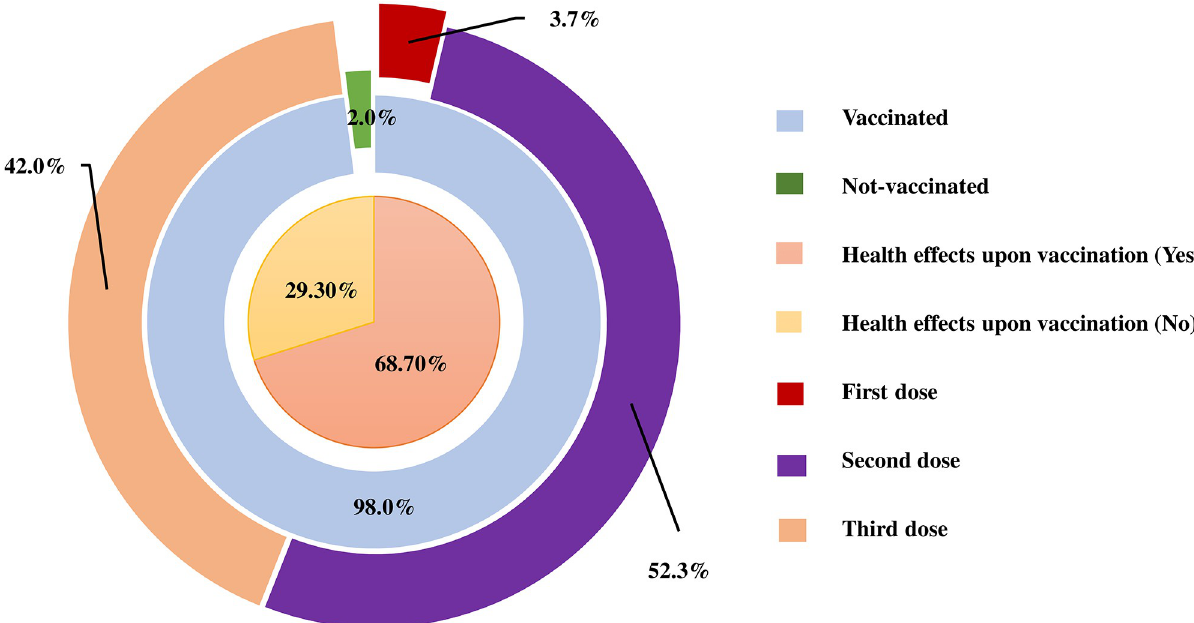
Fig 2. This is the status of COVID-19 vaccination including immediate health consequences among the respondents (n = 300).